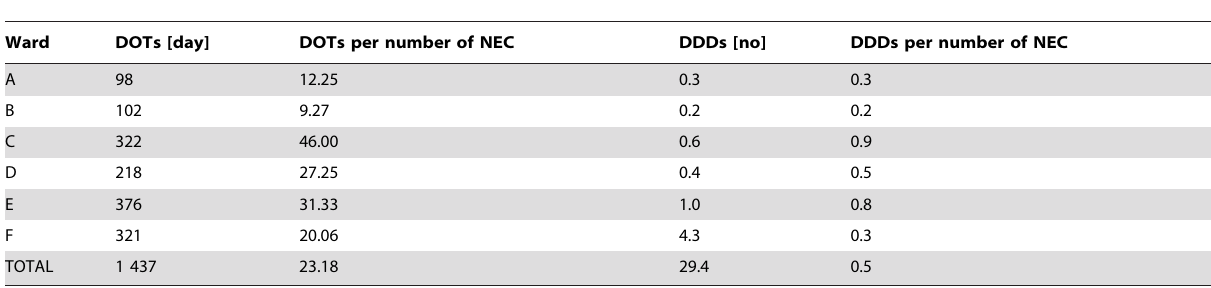
Table 3. Antibiotic usage in NEC cases according to studied